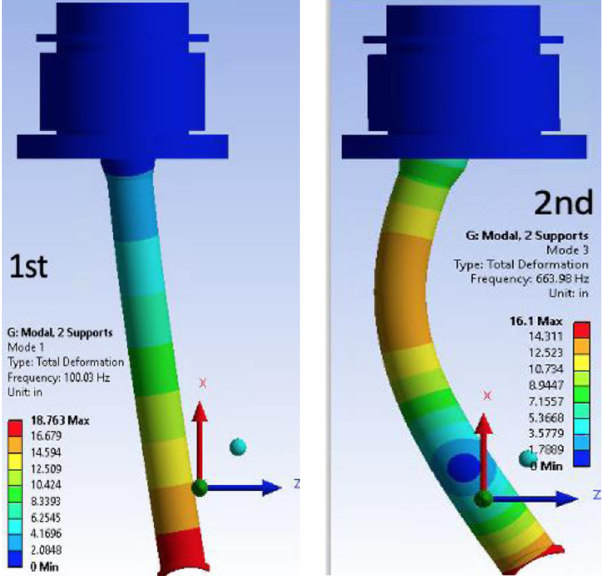
FIG. 12. Modal analysis results.